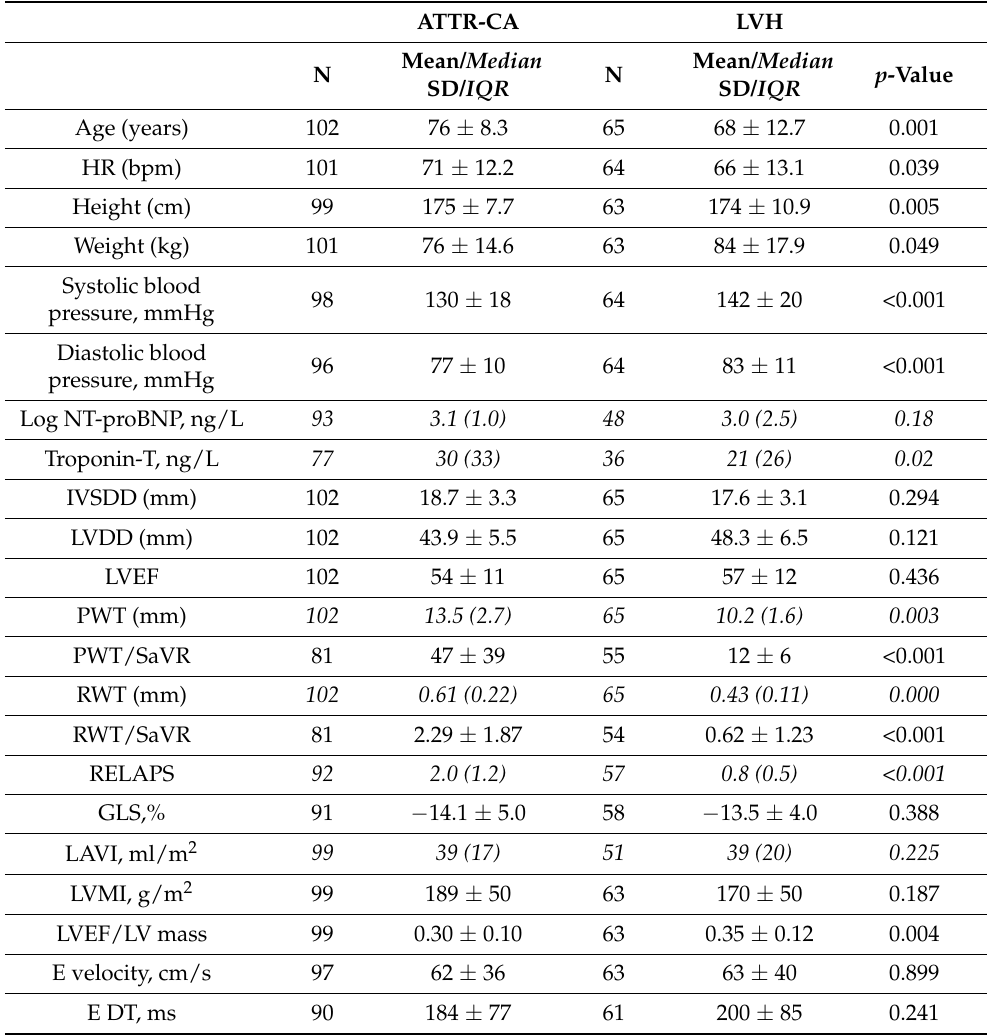
Table 1. Data shown presented as mean ± SD or median (IQR) (Median(IQR) in Italic style). HR = heart rate, IVSDD = interventricular septal diameter diastole, LVDD = left ventricular diastolic diameter, LVEF = left ventricular ejection fraction, PWT = posterior wall thickness, RWT = relative wall thickness, RELAPS, relative apical sparing, GLS = global longitudinal strain, LAVI = left atrial volume index, LVMI = left ventricular mass index, E = early diastole, and DT = deceleration time. ATTR-CA LVH Mean/ N